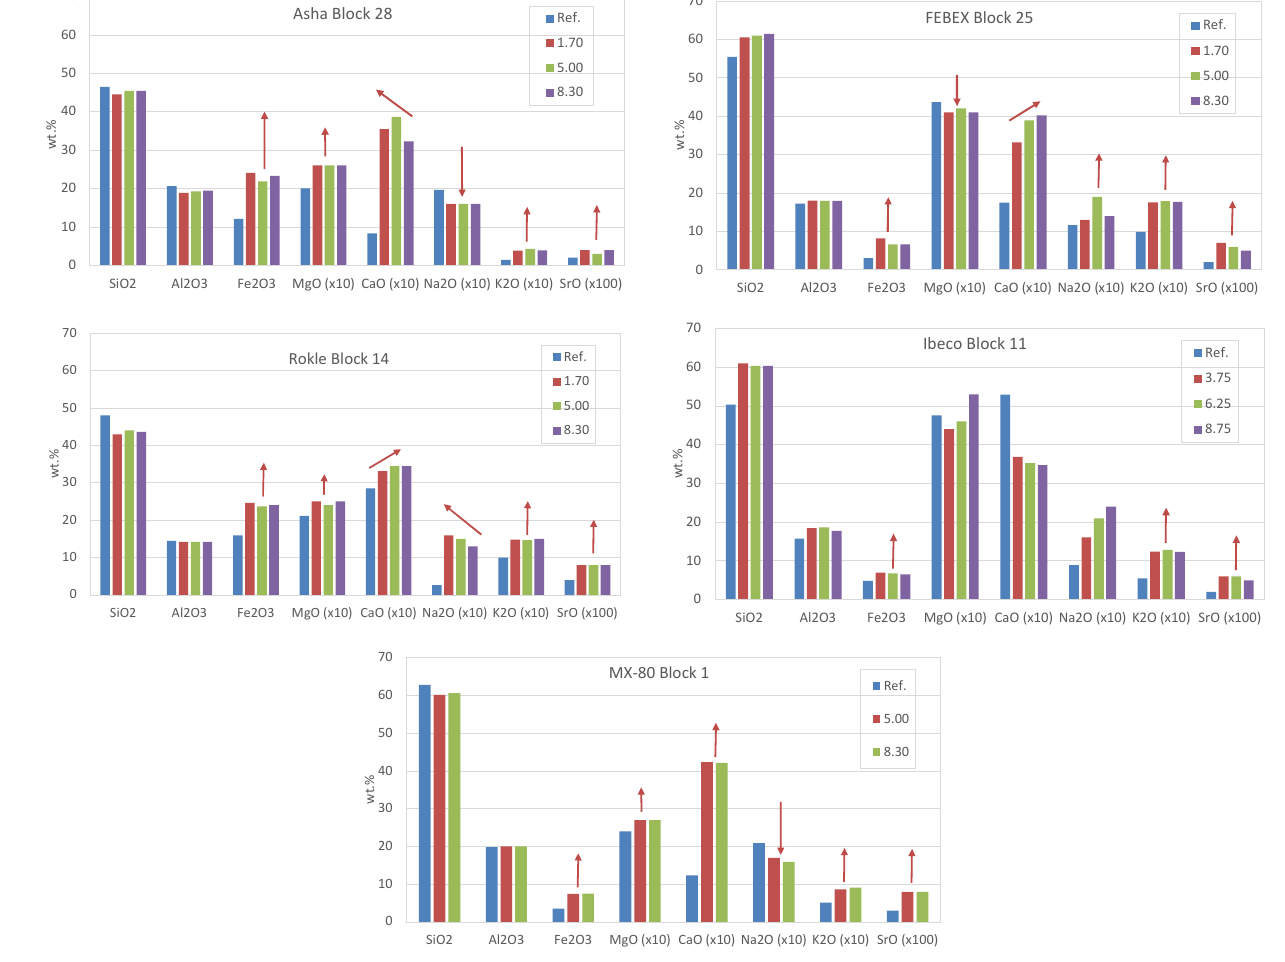
Figure 12. Chemical composition of the solid phase (total fraction) prior to and after the dismantling of the ABM5 experiment as a function of the heater distance (1.70 (H), 5.00 (M) and 8.30 (G) cm). Arrows: variations of content ( ↑ : increases or ↓ :